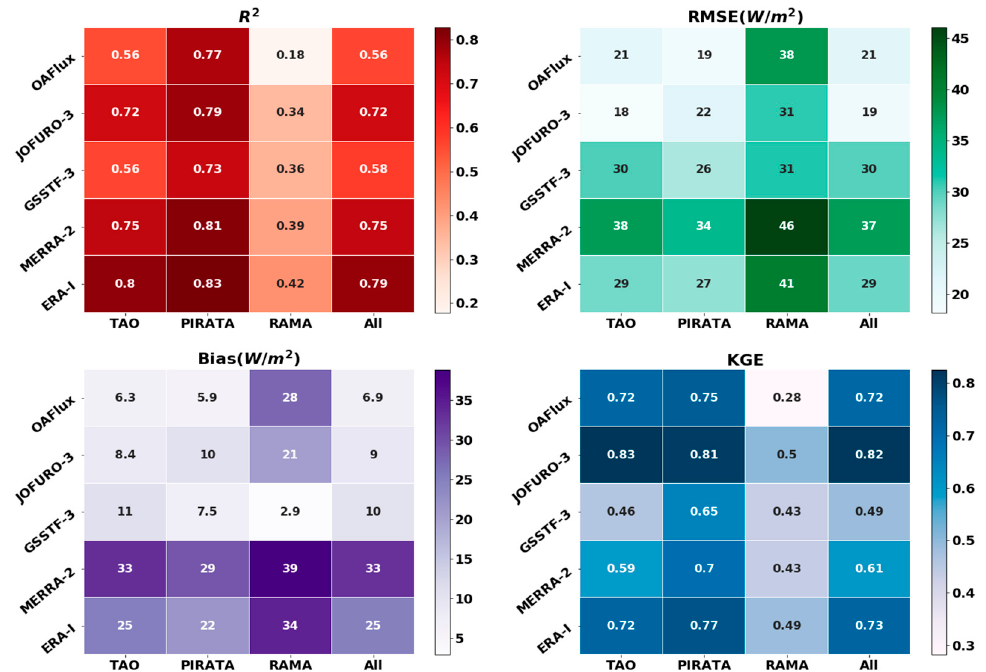
Figure 4. The evaluation parameters ( R 2 , RMSE , bias and KGE ) comparison between the five ocean LHF products against buoy sites observations (unit W m − 2 ).